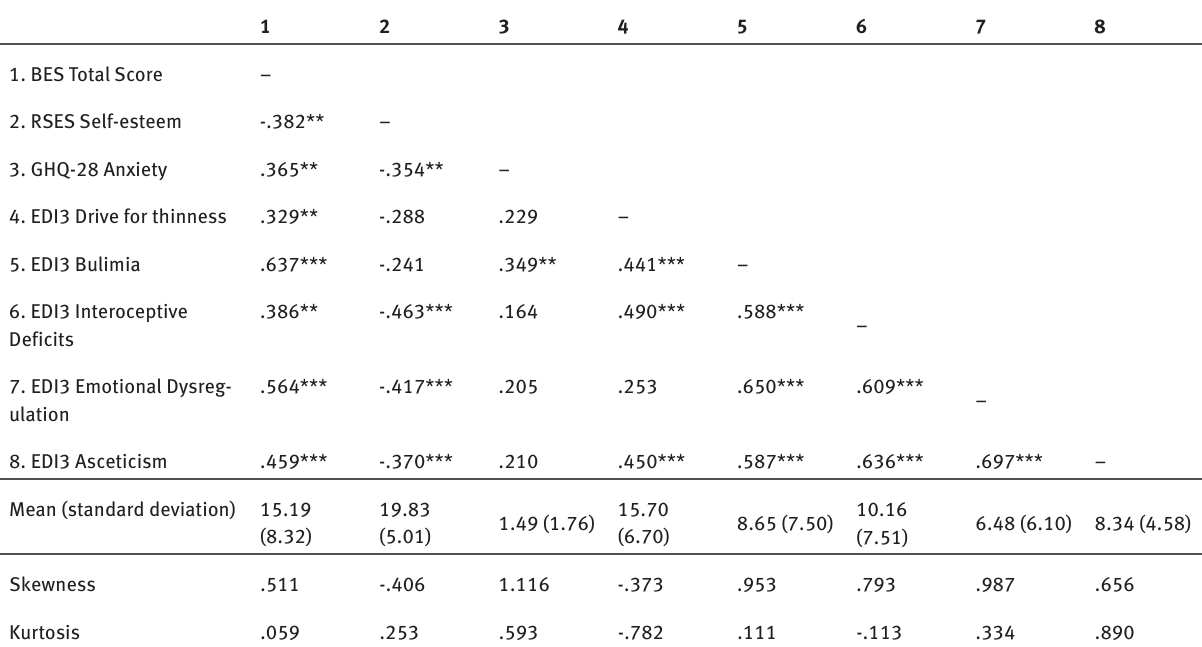
Table 3: Correlations, means (standard deviations), skewness, and kurtosis of the study variables for the complete sample (N=63)